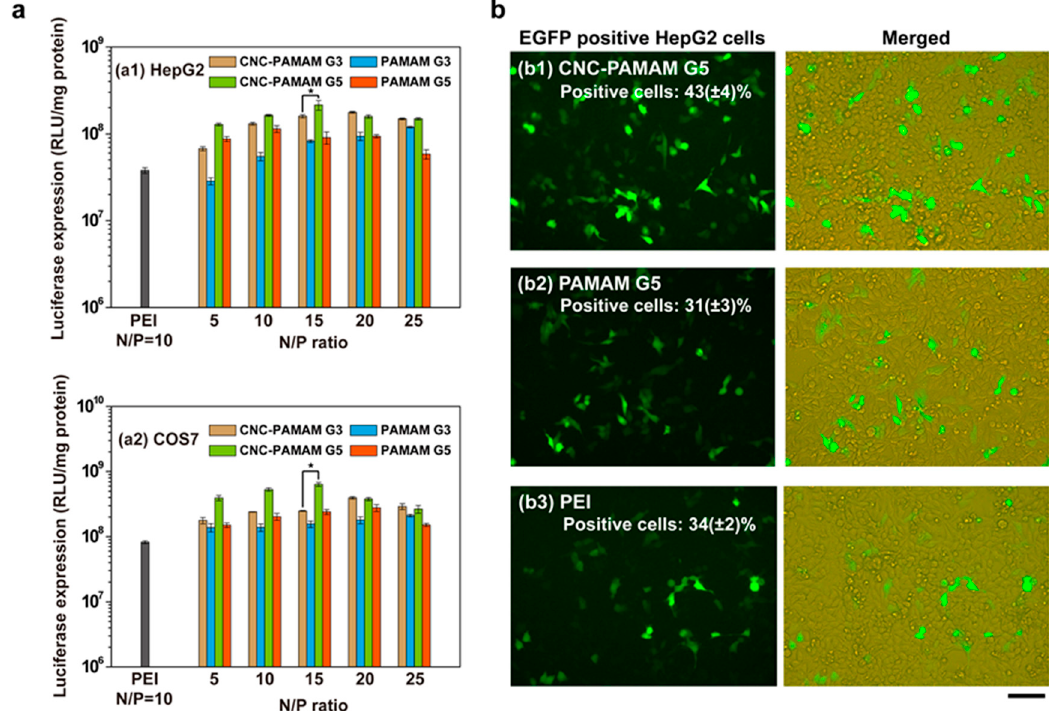
Figure 8. ( a ) In vitro luciferase gene expression mediated by CNC-PAMAMs and PAMAMs in comparison with those mediated by PEI in HepG2 and COS7 cells (mean ± SD, n = 3, * p < 0.05), and ( b ) representative images of pEGFP expression mediated by CNC-PAMAM G5, PAMAM G5, and PEI in HepG2 cells (scale bar: 50 μ m).